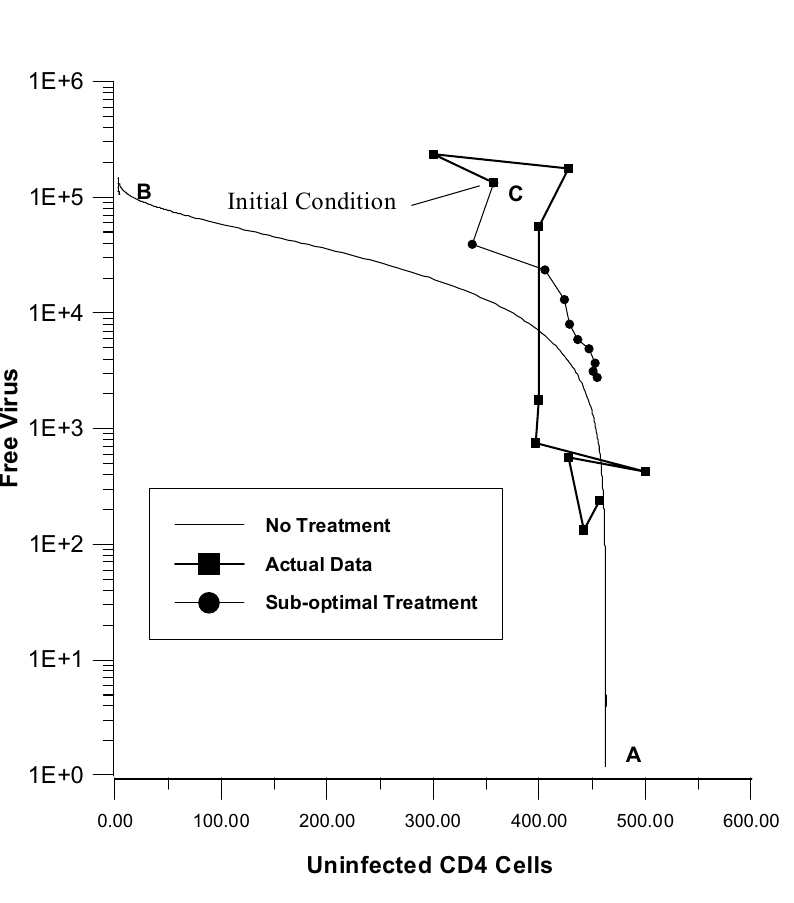
Fig. 1 – Comparison between sub-optimal (computer simulation) and constant-dose treatment schemes (actual data). The point A indicates initial infection; B represents an advanced stage on AIDS without treatment; C represents the condition at the beginning of the sub-optimal